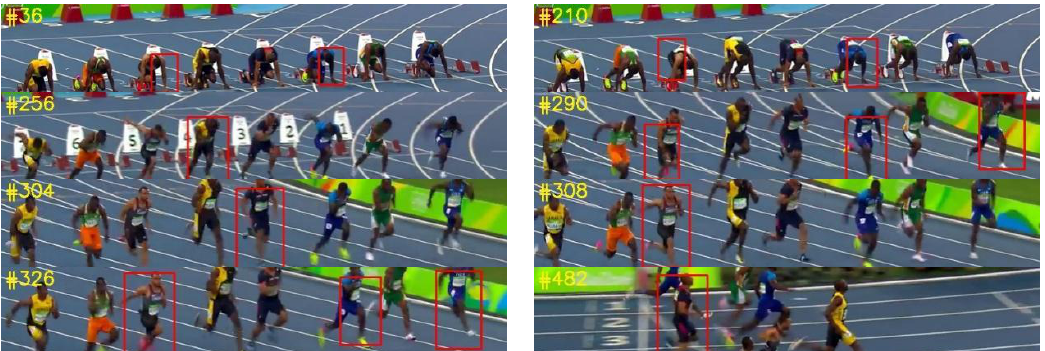
Figure 7. Athletes detection results of Video Sequence I.